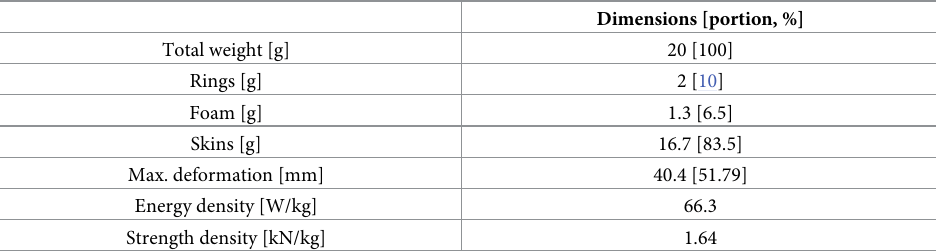
Table 4. Specifications of UH-PAM.